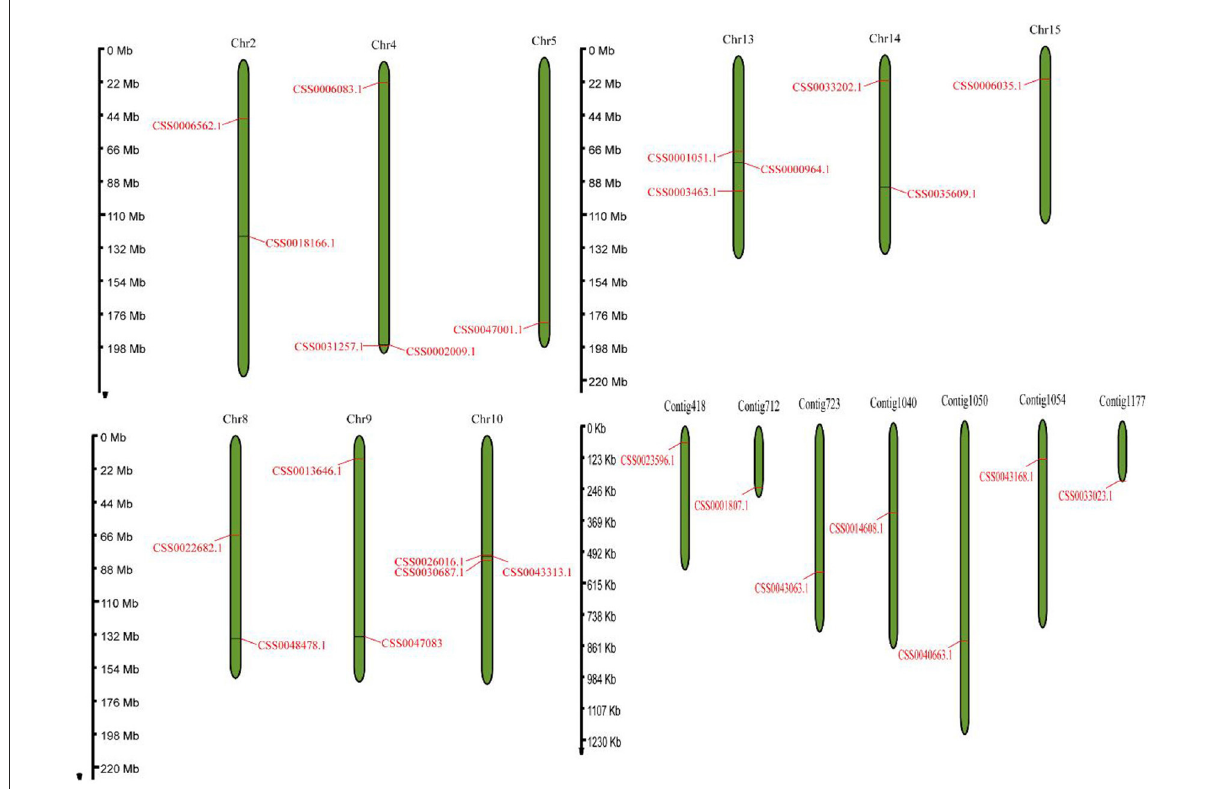
FIGURE1 Genome location of the OVATE genes. The distribution of OVATEs on chromosome and contig with a scale bar was displayed in megabase (Mb).